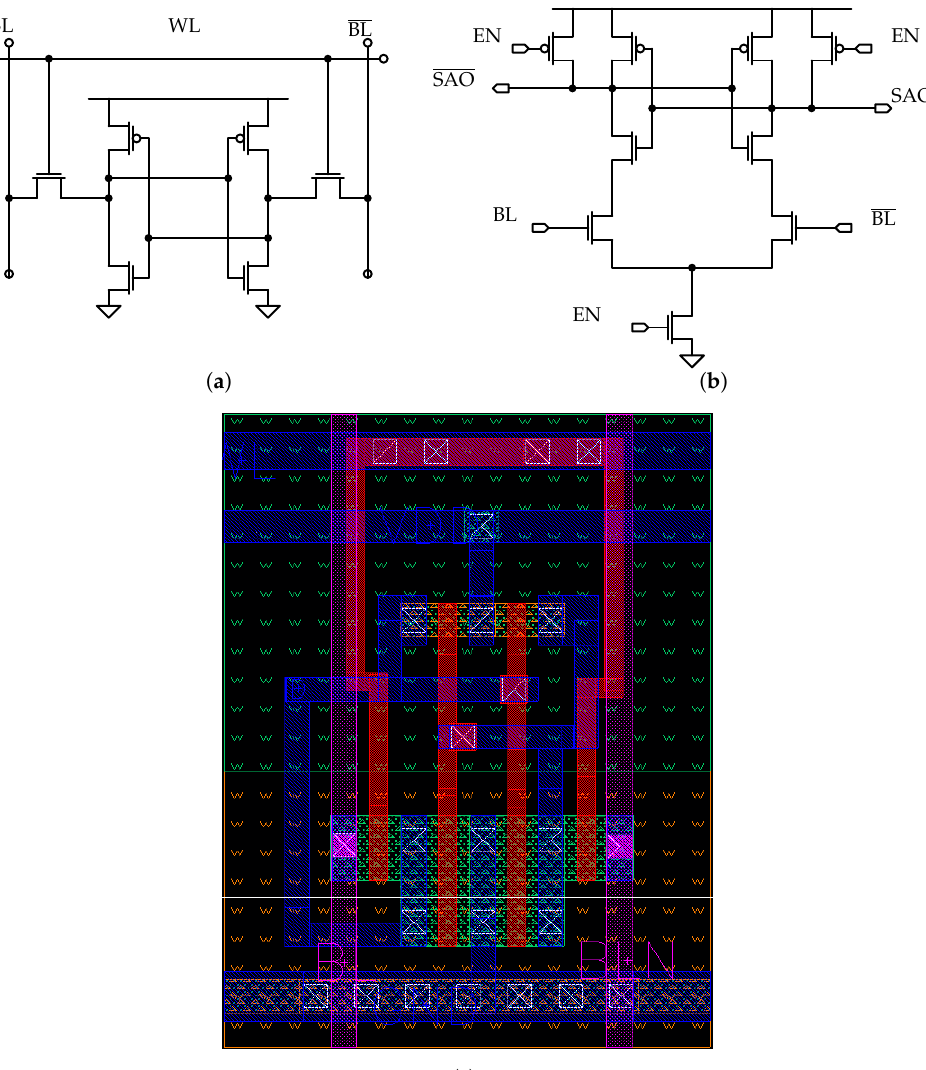
Figure 1. The SRAM cell and SA. ( a ) The 6T cell. ( b ) The SRAM sense amplifier (SA) [33]. ( c ) The SRAM cell